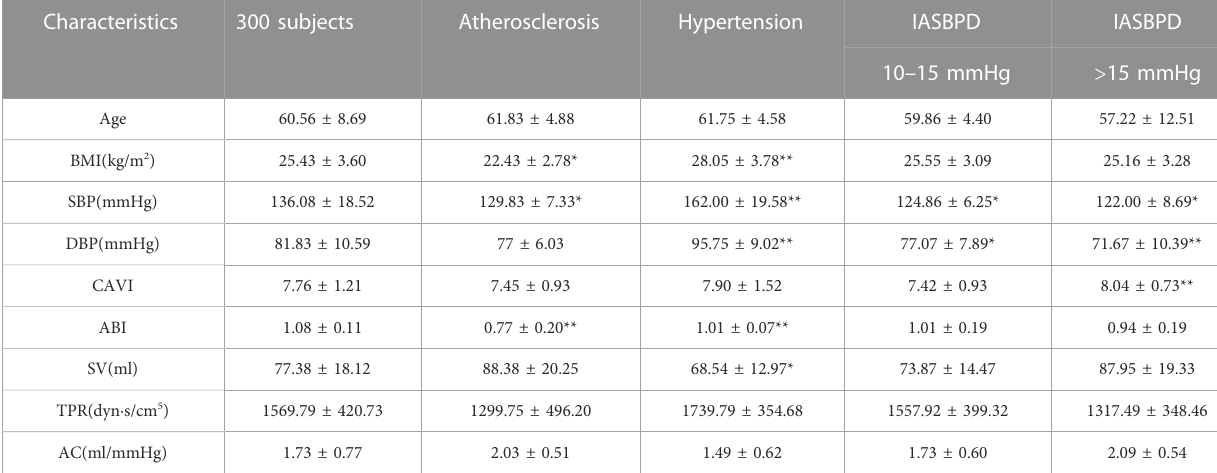
TABLE 2 Basic characteristics in cardiovascular diseases. Characteristics